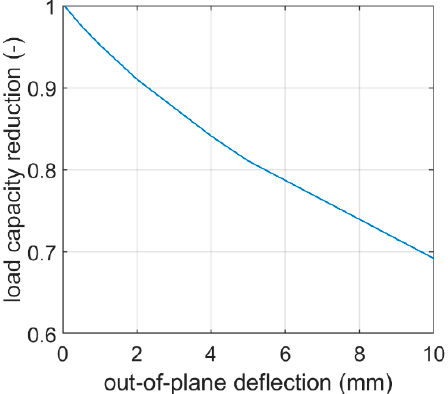
Figure 11. Influence of the imperfections on the load capacity of the BC-780 box.